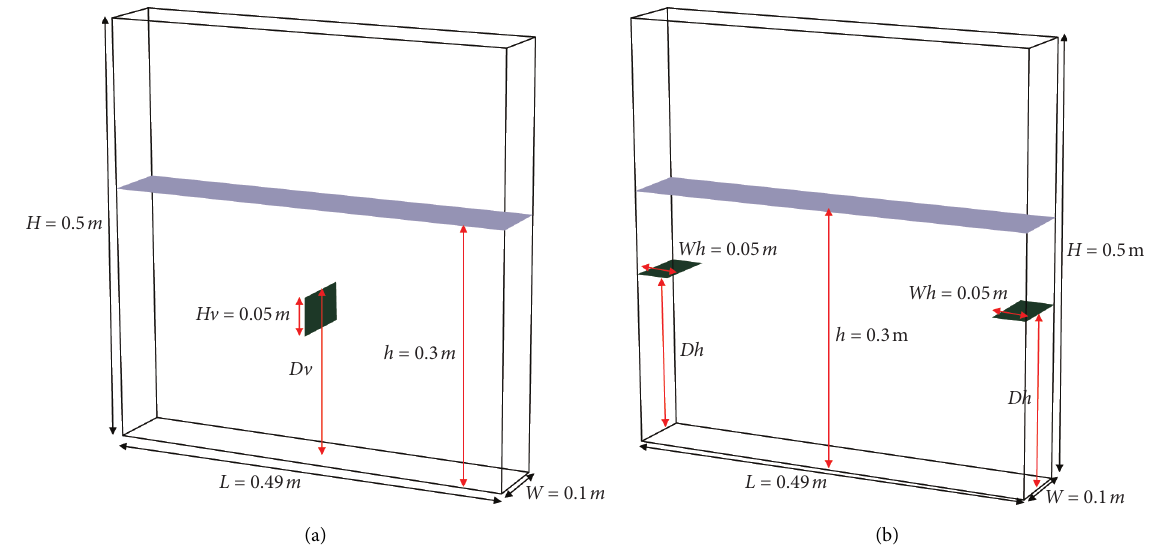
Figure 5: Baffle configurations in the present study: (a) vertical baffle and (b) horizontal